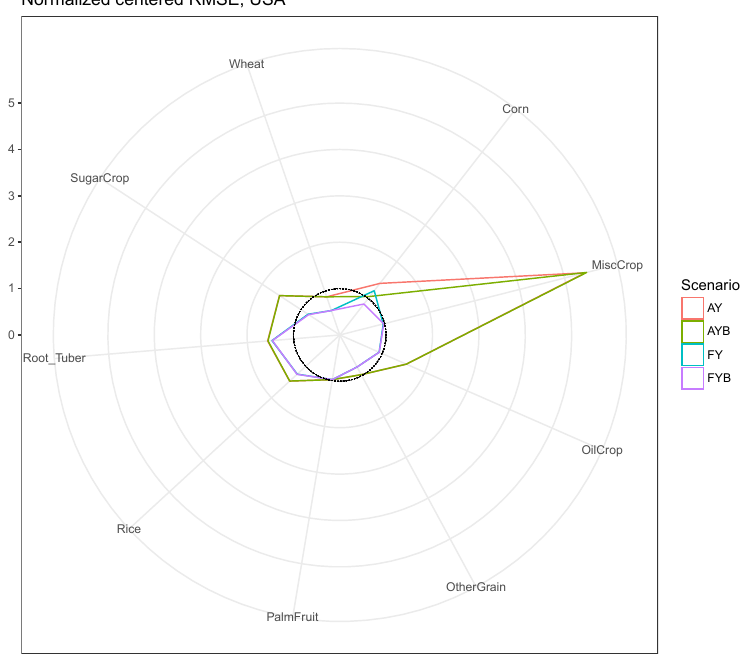
= 1; v (cid:48) compares ij ij